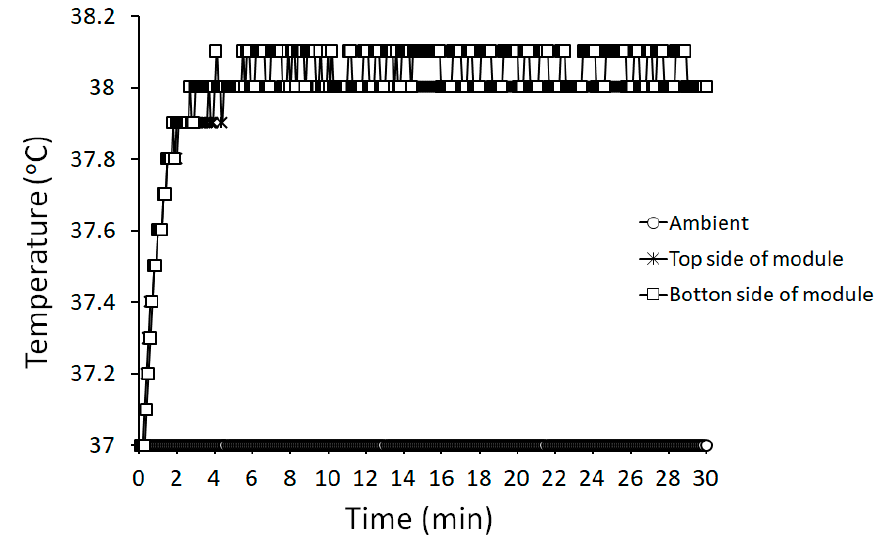
Figure 5. Temperature rise curve of our implantable biomicrosystem under normal operation.